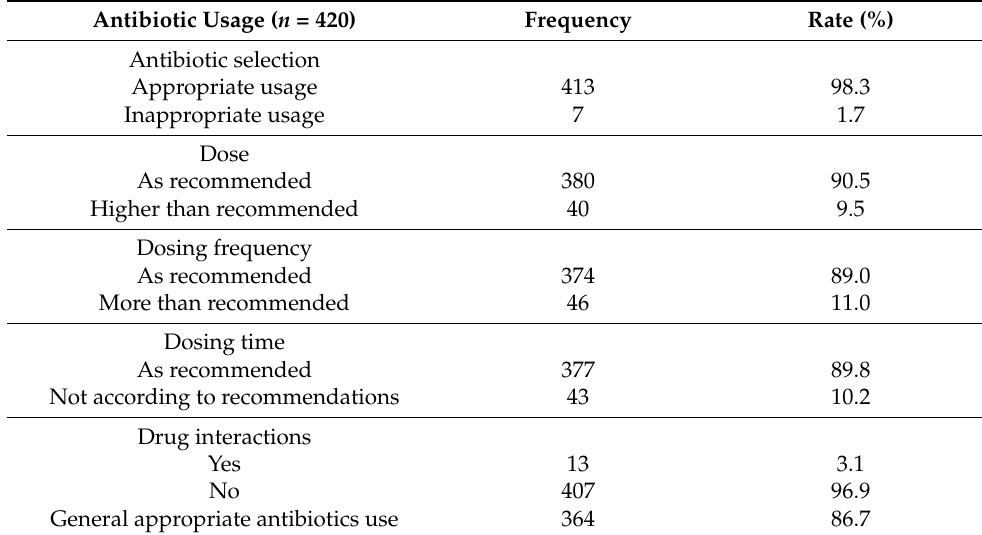
Table 2. Appropriate antibiotic usage.